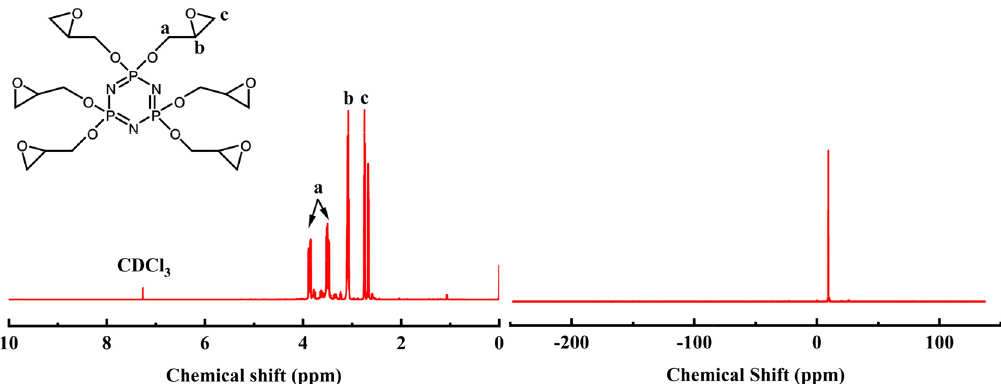
Figure 2: The 1 H NMR and 31 P NMR spectra of HCCP -